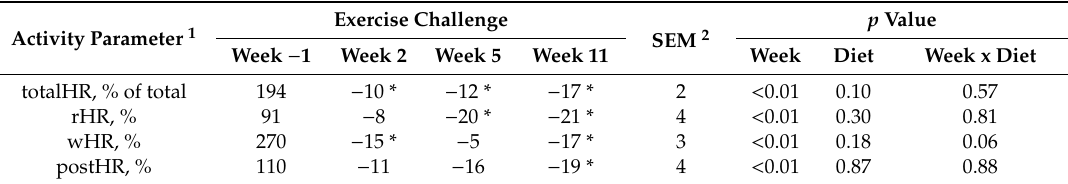
Table 2. Change from baseline (week − 1) as proportion of heart rate at rest, work, and post-exercise on week − 1, 2, 5 and 11 challenges in sled dogs running at a pace of 15 km / h for 4 km. Exercise Challenge Activity Parameter 1